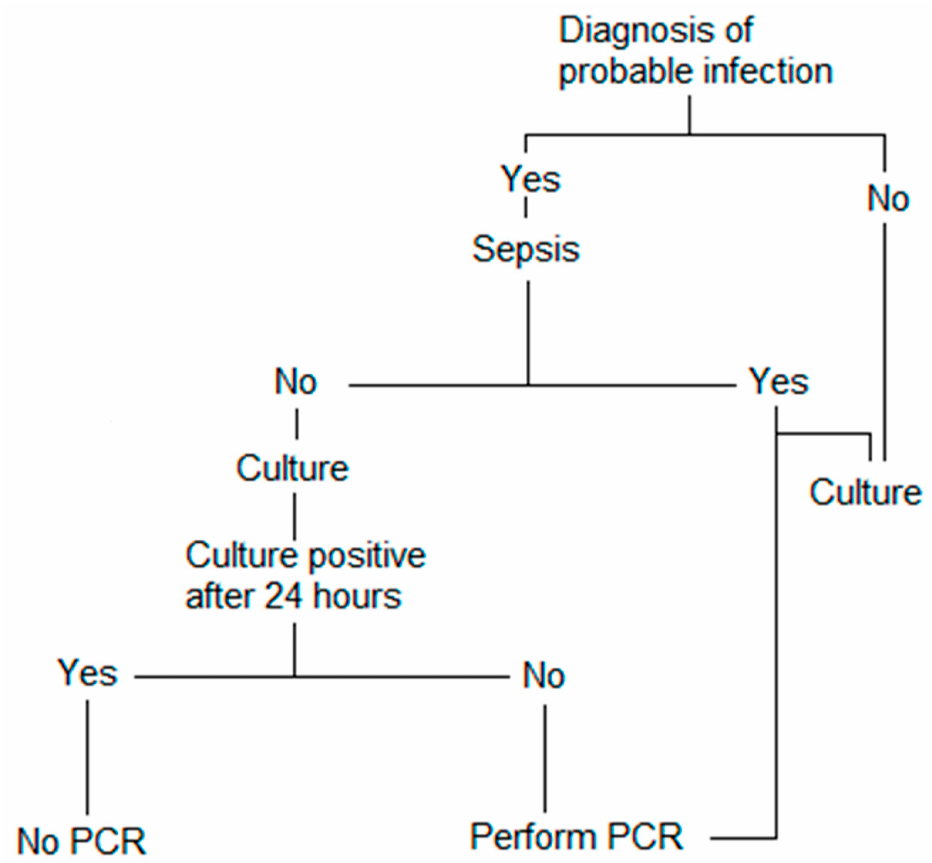
Figure 1. Potential scheme for the incorporation of molecular biology in PJI diagnosis in a cost- effective